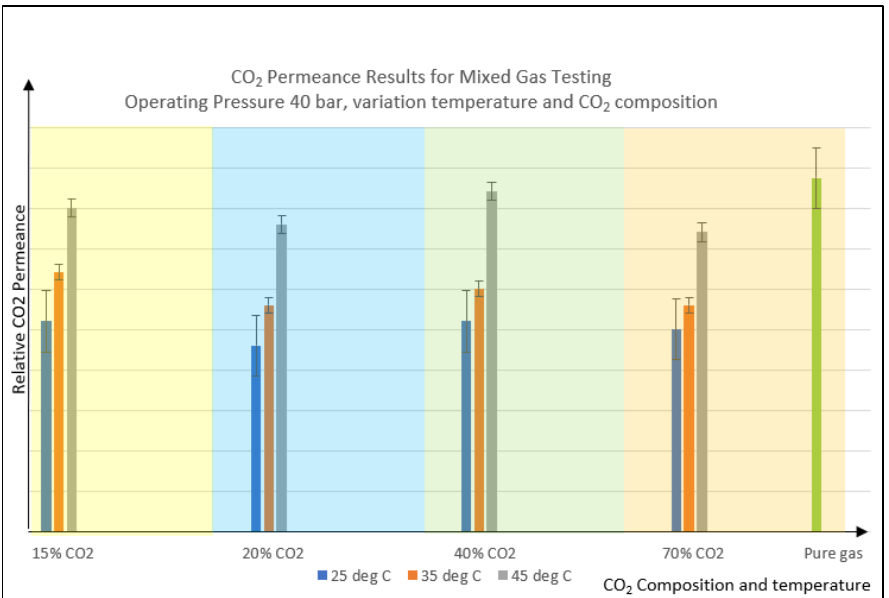
Figure 5. CO 2 permeance result for mixed gas testing vs. variation of CO 2 composition and feed temperature. Note: Pure gas testing condition is 25 °C temperature with 3 to 7 barg applied pressure.